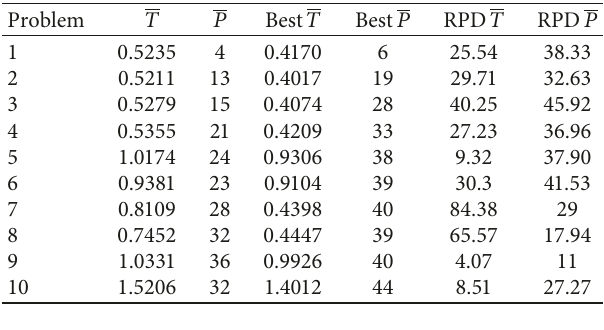
Table 9: Values of RPD criteria for